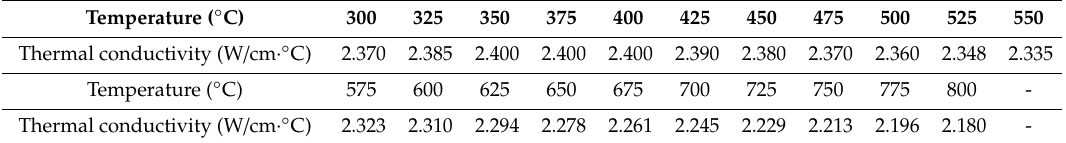
Table 3. Thermal conductivities of 5A06 aluminum alloy at di ff erent